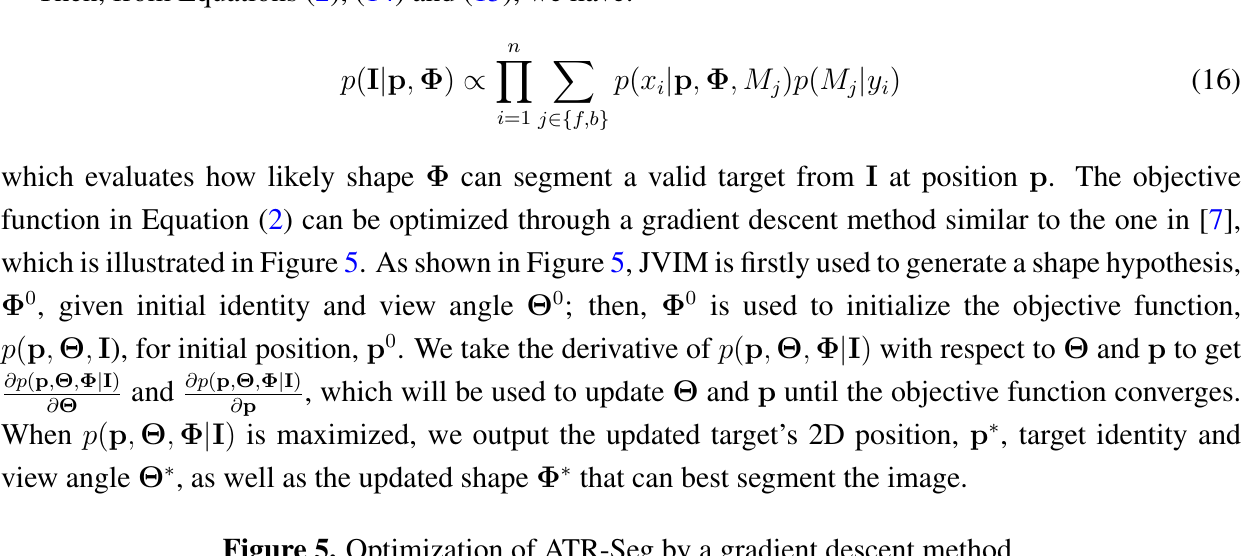
Figure 5. Optimization of ATR-Seg by a gradient descent